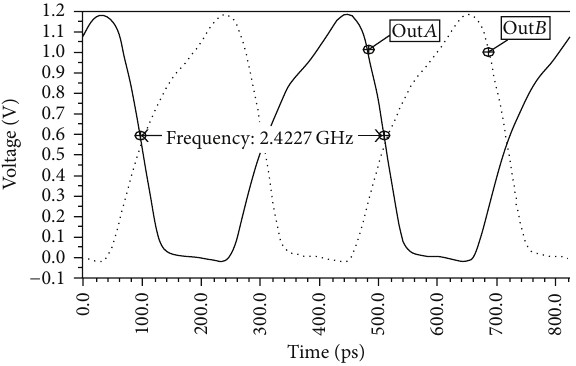
Figure 5: Simulated output of the proposed